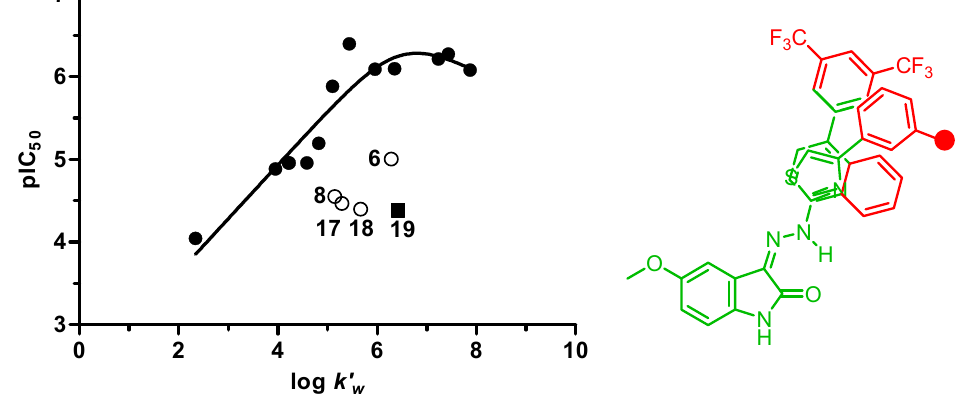
Figure 3. Left : Bilinear relationship (Kubinyi’s model) between A β aggregation inhibition potency (pIC 50 ) and lipophilicity, as assessed by RP-HPLC (log k’ w ). Data points deviating from the bilinear relationship are represented as unfilled circles ( 6 , 8 , 17 , 18 ) and filled square (the only non-isatin derivative, ( 19 ). Right : Superposition of bidimensional structures of molecules 6 , 8 , 17 and 18 behaving as strong outliers; moieties that disrupt binding to A β peptides, most likely because of steric effects (ligands’ exceeding volumes), are colored in red.